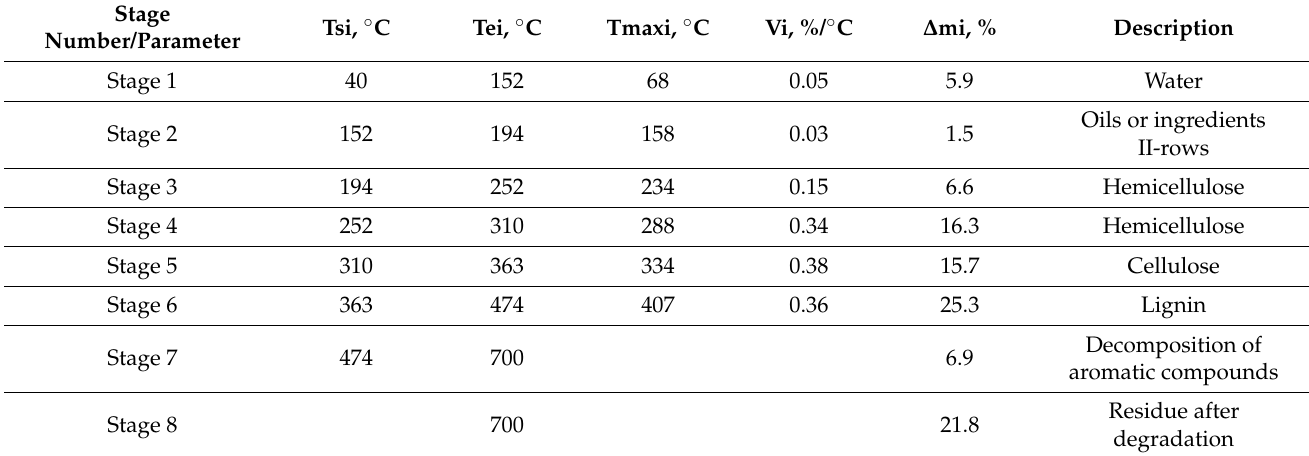
Table 2. Summary of derivative thermogravimetry (DTG) curve analysis results for subsequent stages of filler particle degradation.